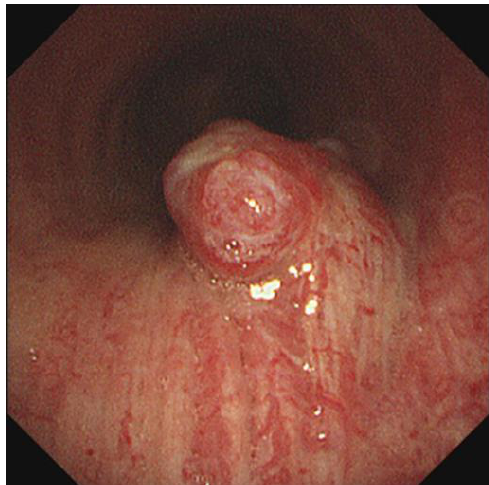
Figure 1. 53-year-old male with tracheal glomus tumor. ( A ) CT lung window setting images; ( B ) pre-contrast enhanced image; ( C ) post-contrast enhanced image; and ( D ) coronal post-contrast en- hanced image. ( A ) The lung window setting CT image showed a 1.4 × 1.3 cm sized protruding mass in the right posterior wall of the mid trachea; ( B , C ) on contrast CT images, the lesion exhibited a high contrast enhancement similar to that of blood vessel; ( D ) the coronal post-contrast-enhanced CT image showed the lesion was located 3 cm above the carina and did not obstruct the airway.